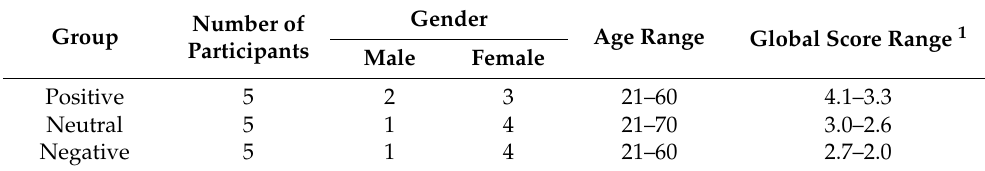
Table 1. Characteristics of the focus groups with global score ranges